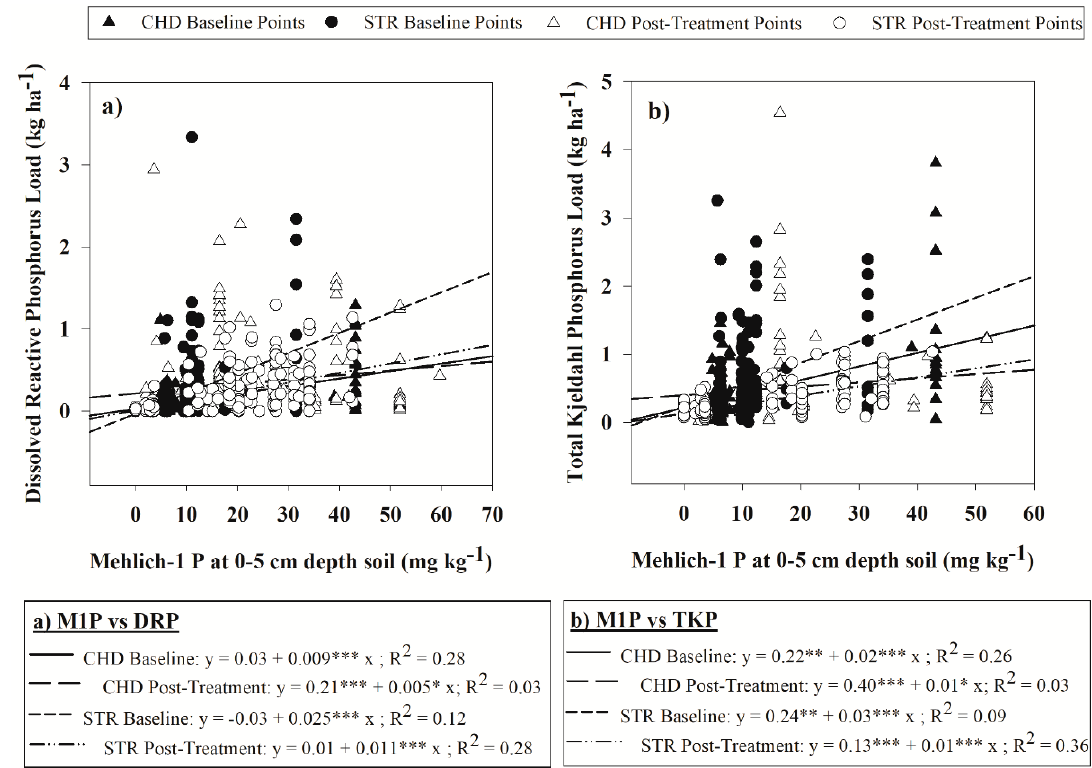
Figure 5. Relationship of ( a ) dissolved reactive phosphorus (DRP) load and ( b ) total Kjeldahl phosphorus (TKP) in runoff water and Mehlich-1 Phosphorus (M1P) in 0–5 cm depth soil compared between Baseline (2015) and Post-Treatment (2016–2018) sampling dates in continuous grazing with hay distribution (CHD) and strategic (STR) grazing treatments. *, **, and *** represent statistical significance at ≤ 0.05, ≤ 0.01, and ≤ 0.001, respectively.